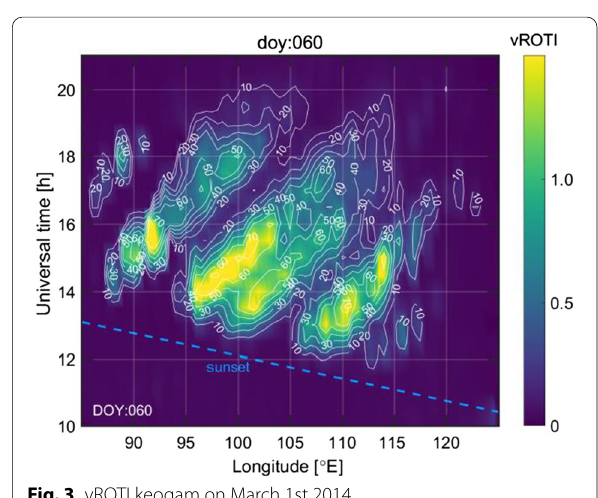
Fig. 3 vROTI keogam on March 1st